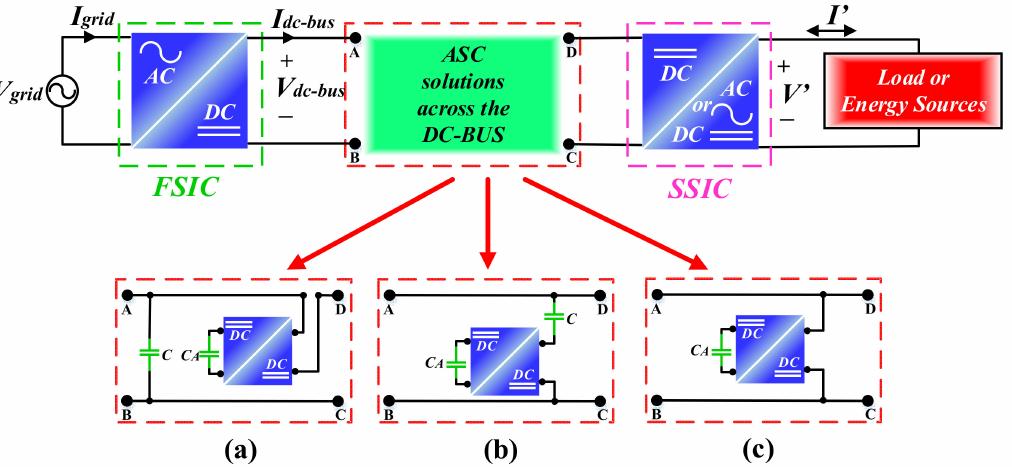
Figure 2. Generalized two-stage, grid-connected ASC-based power conversion system: ( a ) series connection with the converter side; ( b ) series connection with the capacitor side; ( c ) shunt